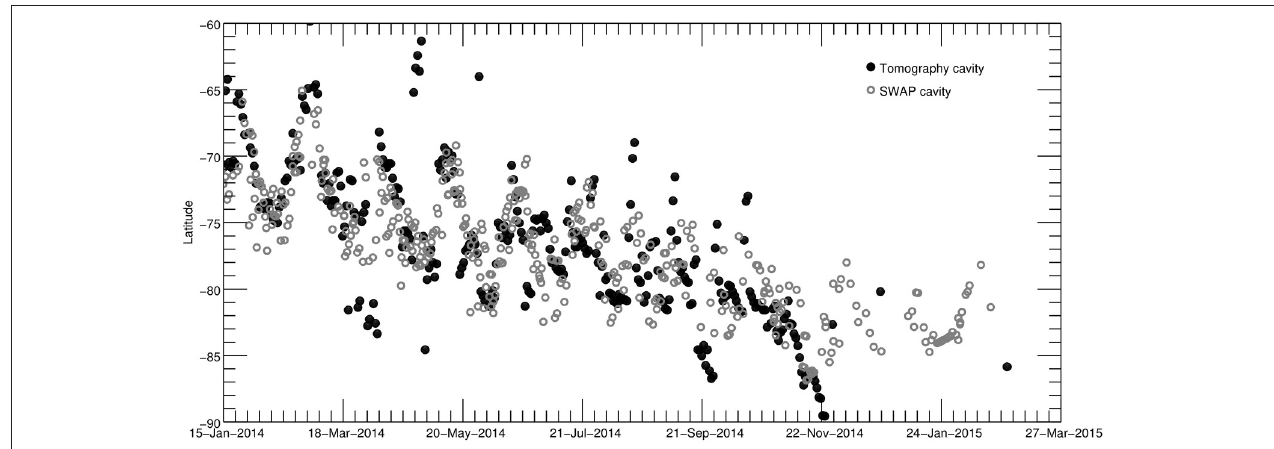
FIGURE 5 | Cavity positions in both tomographic reconstructions (black dots) and images (gray circles), as a function of time. The periodic variations are due to the tilt of the polar crown cavity with respect to the solar rotation axis. On average, there is a very good agreement between the two measurements, demonstrating the consistency of the tomographic